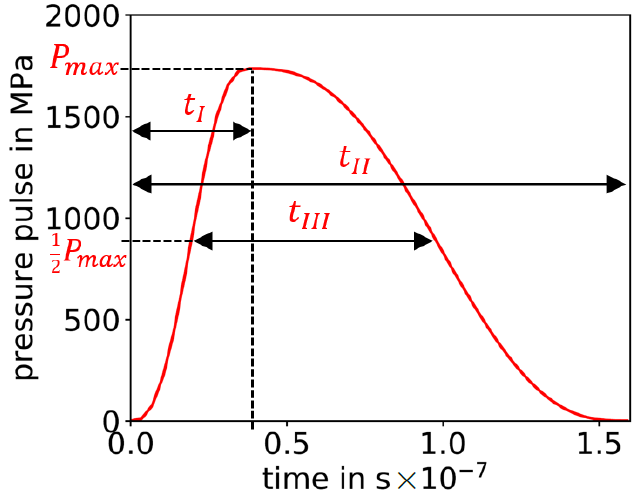
Figure 1. Pressure pulse over time including its uniquely defining parameters: Maximum pressure P max , time of maximum pressure t I and pulse duration t II . As additional information, the full width at half maximum is given by t III